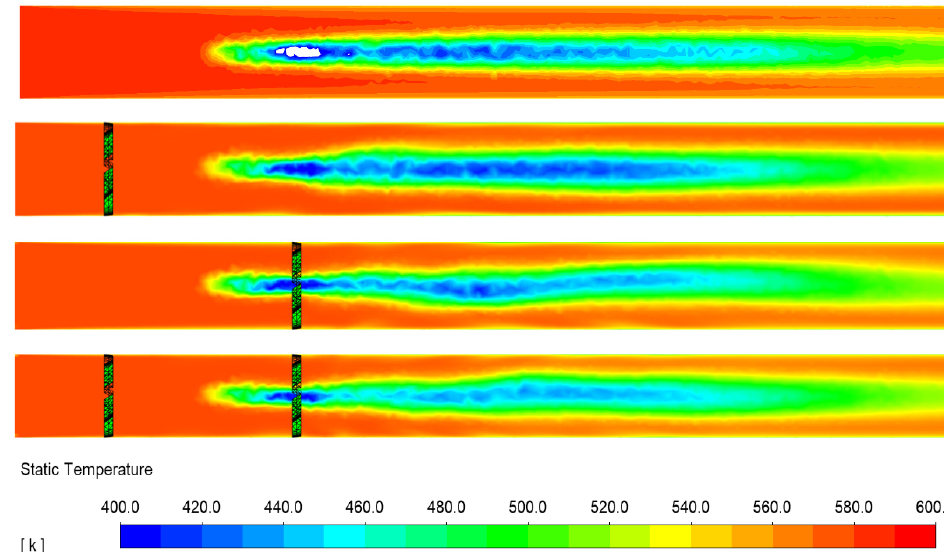
Figure 9. The average reduced temperature of exhaust gas.